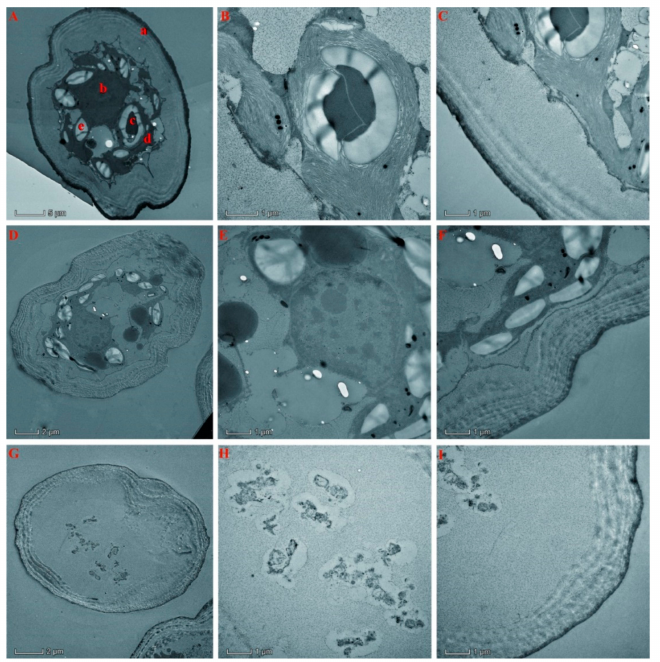
Figure 4. Effect of the essential oil of T. flousiana on the ultrastructure of S. communis . S. communis was treated with the essential oil at different concentrations (50 and 200 µ g / mL) for 96 h and the ultrastructure changes were assessed by TEM). The control cells ( A – C ), treatment with the essential oil of T. flousiana ( D – F ) treated with the essential oil of T. flousiana at 50 µ g / mL and ( G – I ) treated with the essential oil of T. flousiana at 200 µ g / mL). a: cell wall; b: nucleus; c: chloroplast; d: thylakoid; e: starch